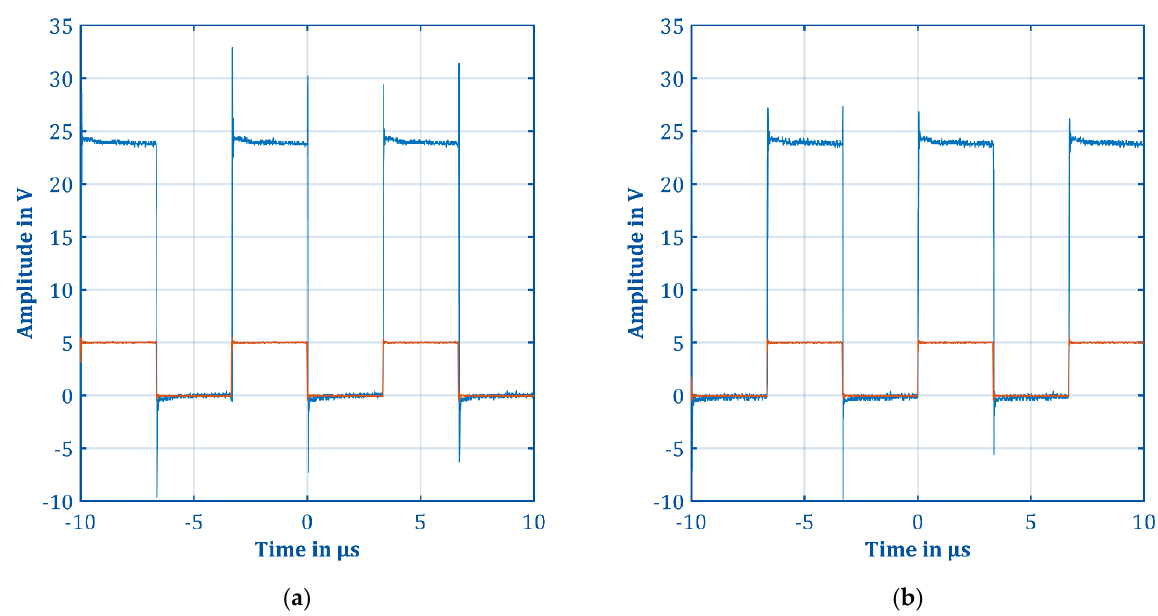
Figure A1. ( a ) Left output of the control electronics in blue with the corresponding input signal in orange from the Agilent 81150 A function generator, at 150 kHz with the Circular PCB transformer; all other transformers look almost identical. ( b ) Shows the inverted signal of the other output of the control signal at the same time; again, blue is the output signal and orange is the signal generator.